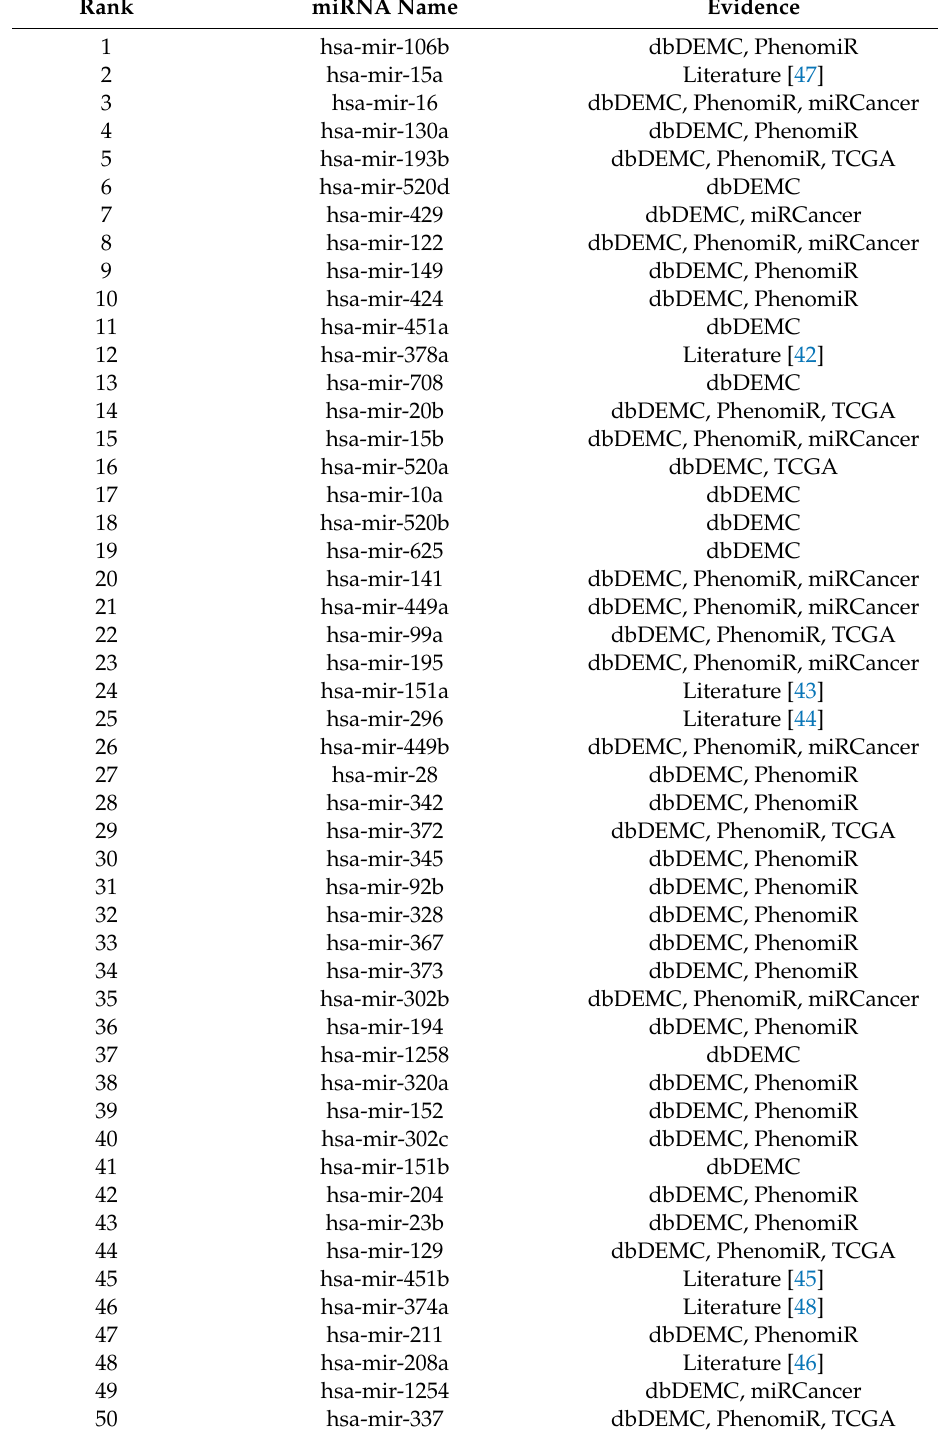
Table 4. The top 50 lung neoplasms-related